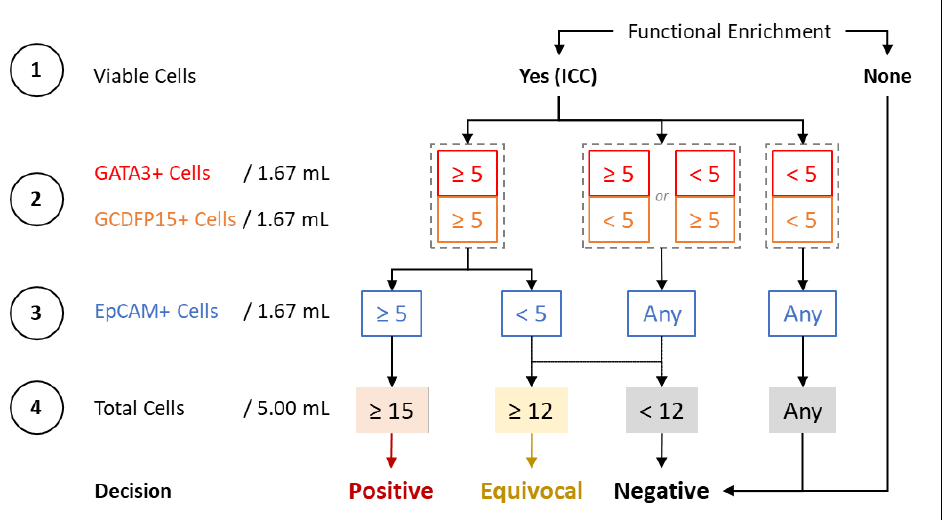
Figure 2. Decision matrix for classifying samples. The detection threshold for breast-adenocarcinoma-associated CTCs (BrAD-CTCs) is ≥ 15 PanCK cells/5 mL, which is constituted by the detection of ≥ 5 GATA3+, PanCK+, and CD45-cells, along with ≥ 5 GCDFP15+, PanCK+, and CD45- cells, as well as ≥ 5 EpCAM+, PanCK+, and CD45-cells in the respective aliquots. Depending on the number of each type of marker positive cells, samples are marked as positive, equivocal or negative. The decision matrix bestows priority to GATA3 and GCDFP15 over EpCAM while classifying samples to ensure specificity for BrAD over other epithelial malignancies where EpCAM+ cells may be detected but breast-specific markers would be absent. Thus, while the test can detect EpCAM+, PanCK+, and CD45-cells, which may be present in various epithelial malignancies, it specifically reports only BrAD-CTCs.